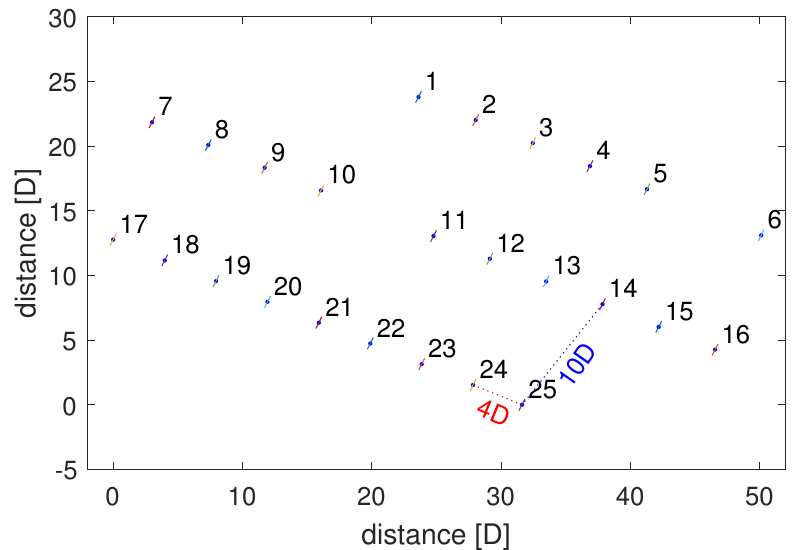
Figure 3. Layout of the Reference wind farm. The axes scales are given in number of rotor diameters (D). The wind speed distribution and the wind direction rose for this site can be found in Figure 4. The Weibull distribution parameters are provided as function of the wind direction; their yearly average values are A = 9.20 and k = 1.95 at 69.9 m height. The turbulence intensity is provided as a function of the wind speed and wind direction. The most dominant wind directions are in the Western sector. The distances between the wind turbines are varying between 4-10D.